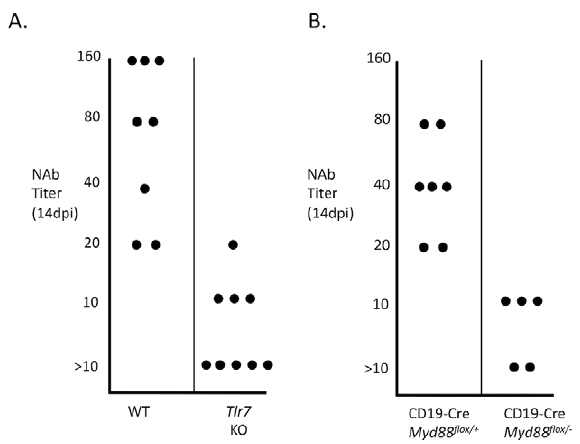
Figure 4. TLR7 and B cell-intrinsic Myd88 are required for a neutralizing antibody response. Serum from infected wild-type (WT) or TLR7-deficient mice ( Tlr7 KO) ( A ), as well as mice with Myd88 deleted in B cells (CD19-Cre/Myd88 flox/ 2 ) ( B ), was diluted over a wide range and incubated with a defined quantity of infectious FV. The effect of the serum on the infectivity of the sample was then measured by focus-forming assay. The neutralizing antibody (NAb) titer was defined as the maximum serum dilution that reduced the infectivity of the virus sample by at least 50%. Each dot represents an individual mouse.